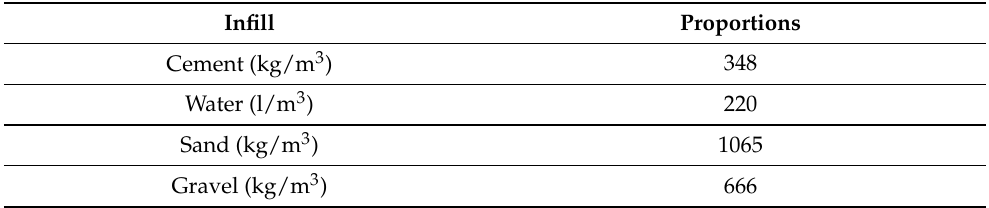
Table 2. Concrete mix